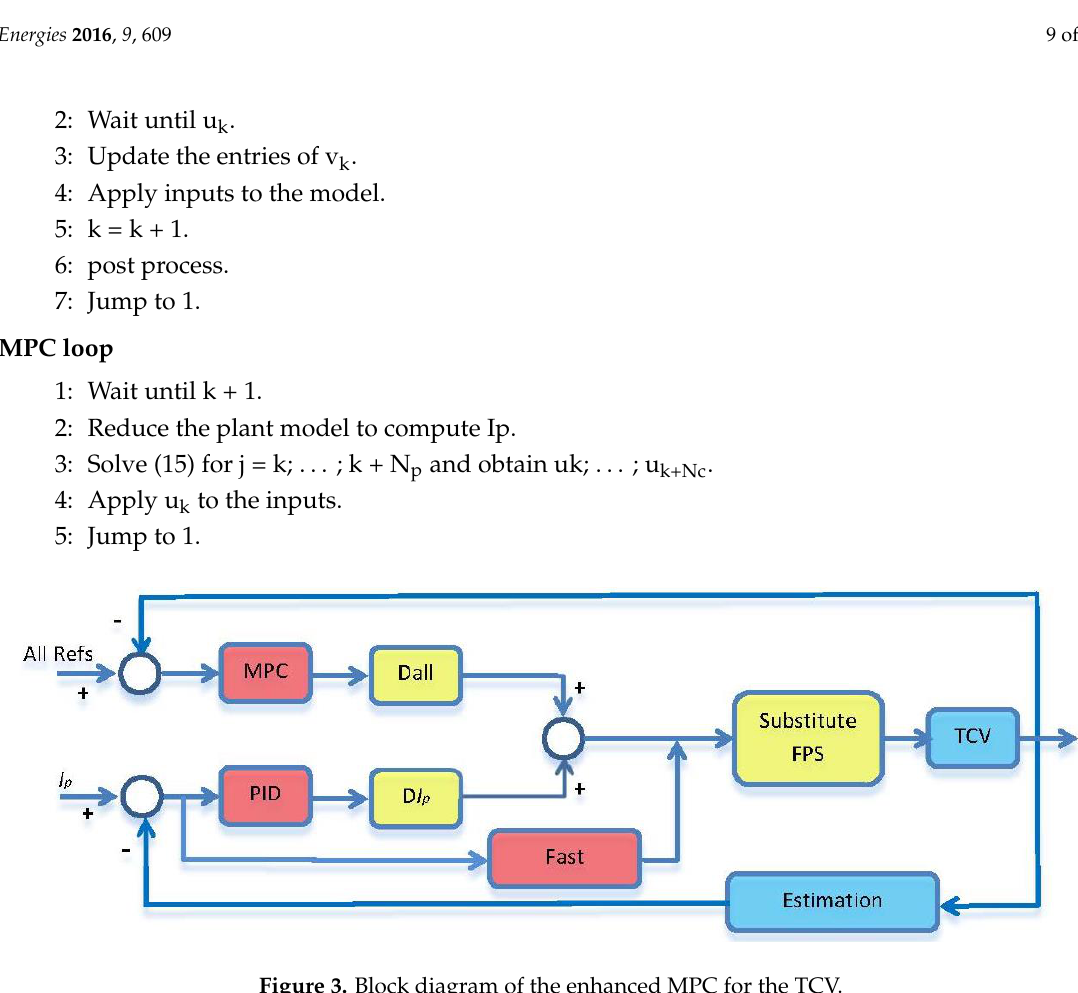
Figure 3. Block diagram of the enhanced MPC for the TCV.